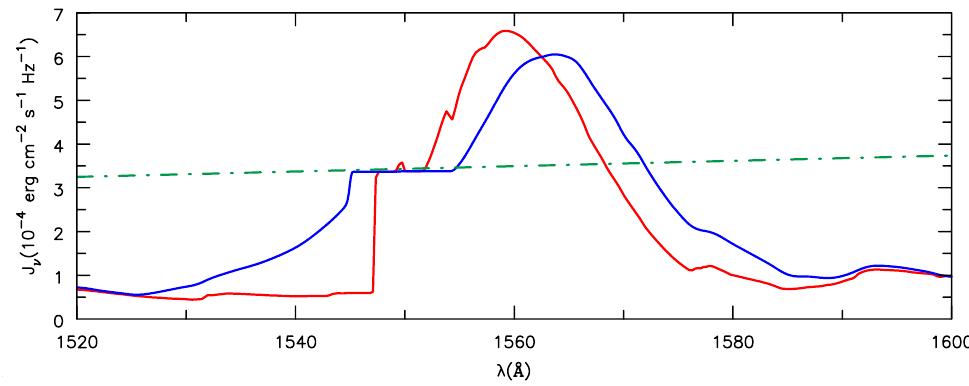
Figure 6. Comparison of the mean intensity (in the comoving frame, red curve) and the blackbody mean intensity (green dashed curve) at a temperature of 1.6 × 10 4 K and a density of ∼ 10 11 electrons cm − 3 —roughly 50% of the emission in C III λ 2297 originates above that density. At this density the C IV 2s and 2p states are collisionally coupled and as a result the radiation field near the wave- lengths of the C IV transitions at 1548, 1551 Å is also close to that of a blackbody. The blue curve is similar to the red curve except that we used a Voigt profile for the line absorption/emission profile (see Equation (15)), rather than the simple Doppler profile (see [4]) which is generally used when computing the atmospheric structure and level populations. The use of a Voigt profile is crucial for explaining the observed profile of the C IV resonance doublet at 1548, 1551Å in WC stars